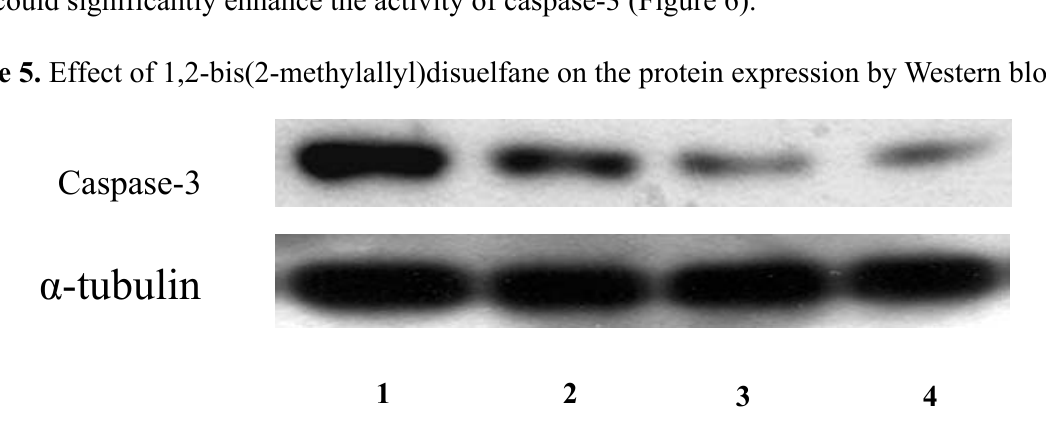
Lane 1: Control; Lane 2-4: 1,2-bis(2-methylallyl)disulfane 50, 100, 150 μ mol/L,